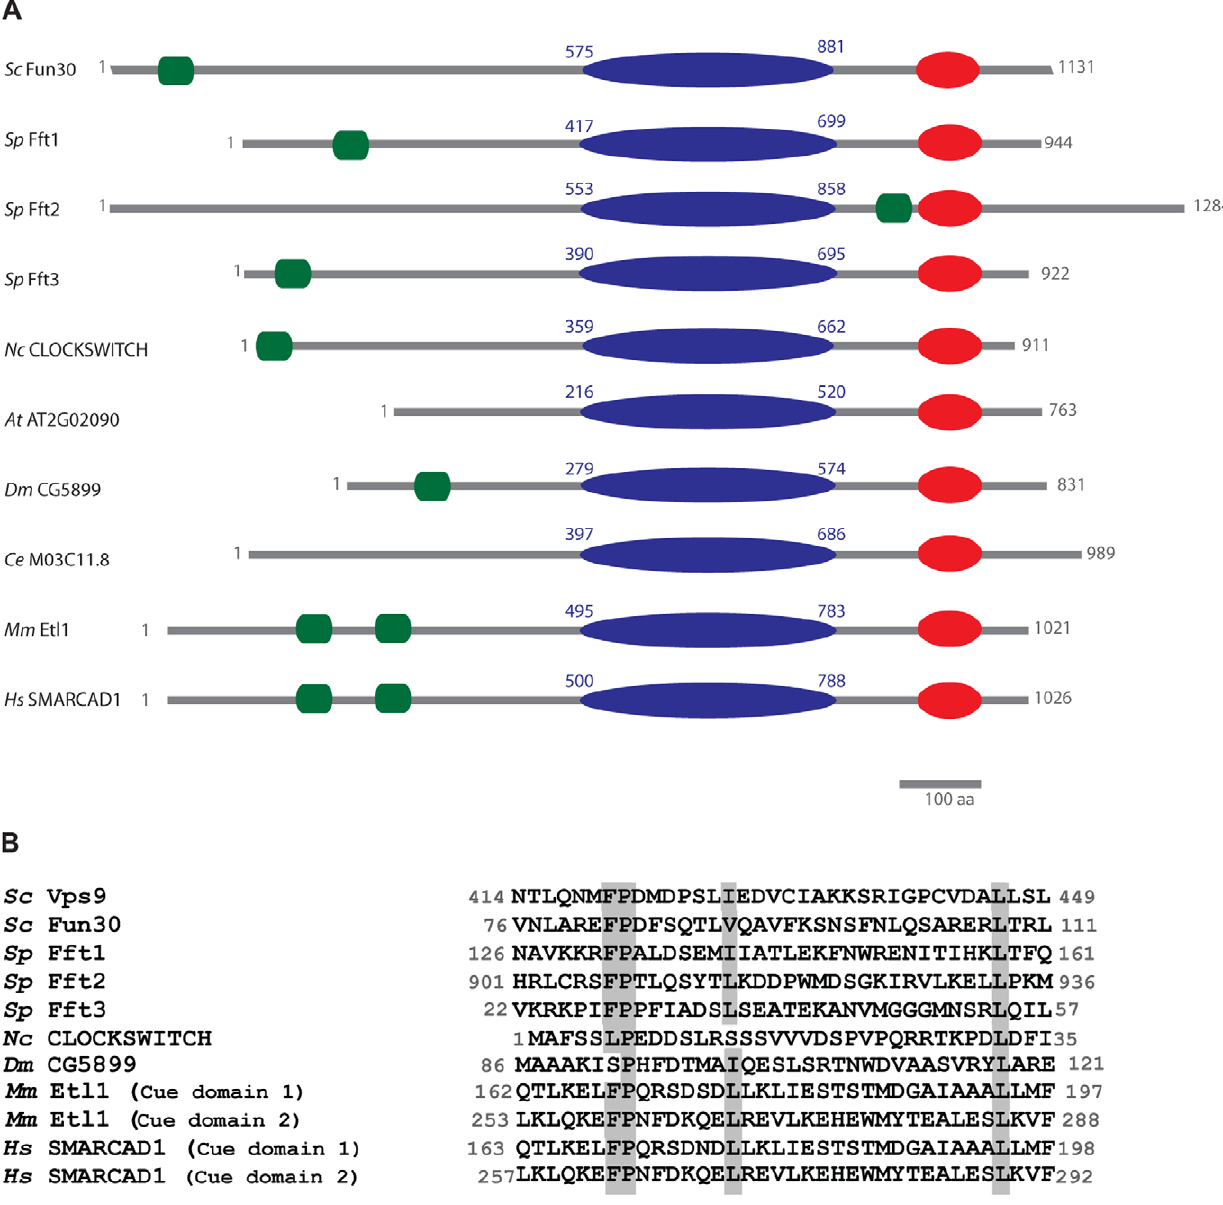
Figure 1. Fun30, Fft1-3, and SMARCAD1/ETL1 are SNF2-factors characterized by putative CUE motifs. A. Diagrams of Saccharomyces cerevisiae ( Sc ) Fun30, Schizosaccharomyces pombe ( Sp ) Fft1, Fft2, Fft3, Neurospora crassa (Nc) CLOCKSWITCH, Arabidopsis thaliana (At) AT2G02090, Drosophila melanogaster (Dm) CG5899, Caenorhabditis elegans (Ce) M03C11.8 and Human / mouse ( Hs, Mm ) SMARCAD1/ETL1 with relative positions of putative CUE motifs (green), SF2 ATPase (blue) and helicase-c domains (red). The amino acid positions for the SNF2_N domains are indicated. CUE motifs were not apparent in AT2G02090 and M03C11.8. B. Sequence alignments of the putative CUE motifs of Vps9, Fun30, Fft1-3, CLOCKSWITCH, CG5899, ETL1 and SMARCAD1. Conserved FP/LP and L positions are indicated by grey